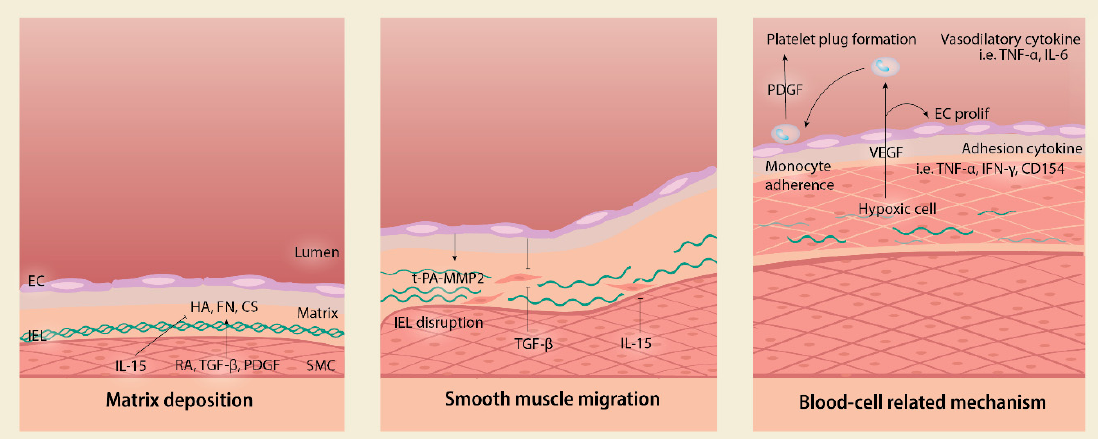
Figure 1. Sequential steps for intimal thickening. Ductal closure is initiated by matrix deposition by smooth muscle cells (SMCs) and endothelial cells (ECs). ECs secrete t-PA that activates MMP-2 and digest internal elastic laminae (IEL). SMC migration is mediated by numerous pathways that will be explored in Figure 2. The blood cell-related mechanism encompasses cells under hypoxic status to secrete VEGF and attract monocytes that mediate PDGF-mediated platelet plug formation. t-PA = tissue plasminogen activator; MMP = matrix metalloproteinase; FN = fibronectin; HA = hyaluronic acid; CS = chondroitin sulfate; RA = retinoic acid; TGF- β = transforming growth factor-beta; PDGF = platelet-derived growth factor; IL = interleukin; VEGF = vascular endothelial growth factor; EC = endothelial cell; IEL = internal elastic laminae; TNF = tumor necrosis factor; IFN = interferon; prolif = proliferation .